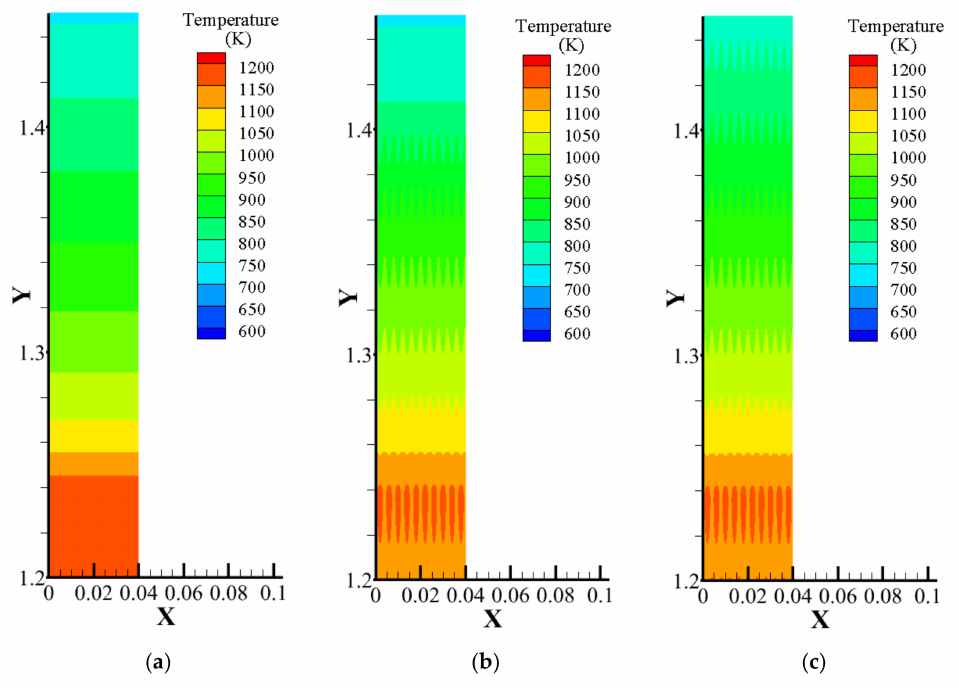
Figure 11. Temperature contour comparison of three models at 108 s with X CH rate of 700 m 3 /h. ( a ) VAM model; ( b ) Multi-scale model; ( c ) PSS